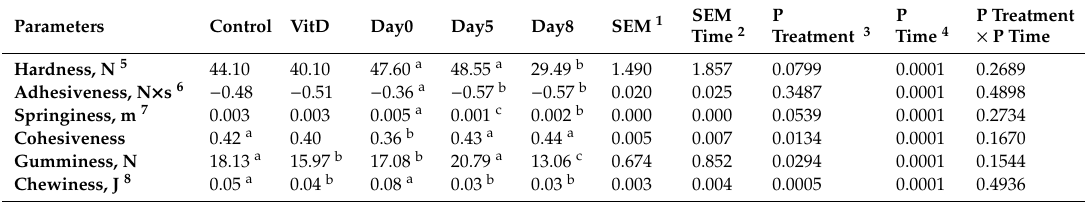
Figure 1. Relationship between thiobarbituric reactive substances (TBARS) values and muscle PUFA free-fatty acids proportion or α -tocopherol concentration from pigs supplemented with vitamin D 3 or without supplementation prior to slaughter (experiments 1 and 2). Table 3. Texture parameters in muscle from pigs supplemented with vitamin D 3 or without supplementation prior to slaughter (experiment